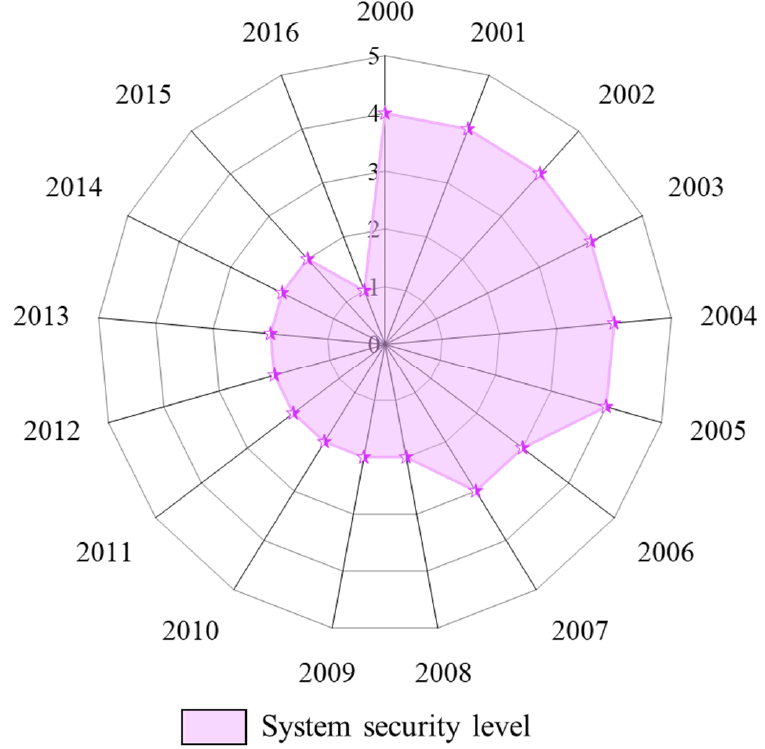
Figure 9. Changes in system safety level values in the period 2000–2016.